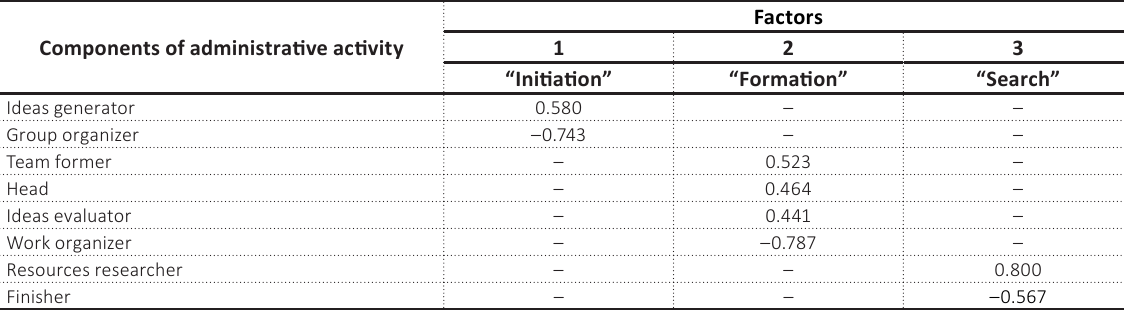
Table 4. Management components of heads of educational institutions (based on factor analysis results) Components of administrative